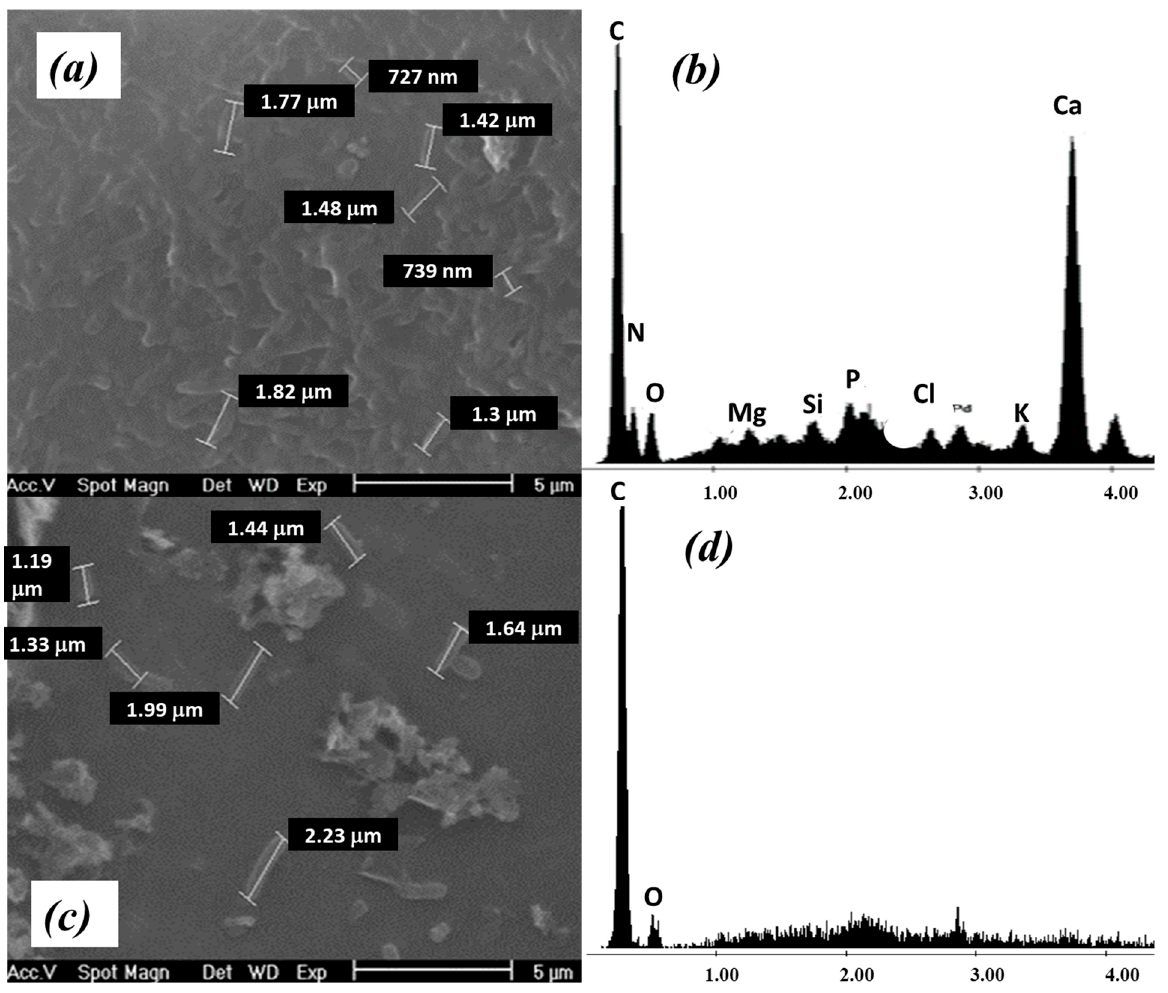
Figure 3. SEM and EDS analysis of P. koreensis /alginate beads system after Cr adsorption at ( a , b ) 0 h and ( c , d ) 48 h.